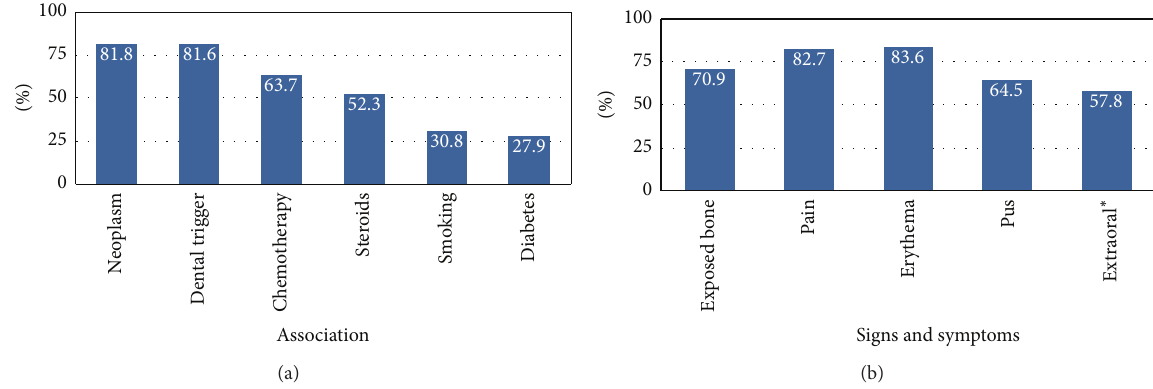
Figure 2: Immunosuppressed association (a) and clinical presentation (b) of the BRONJ population (𝑛 = 814) .